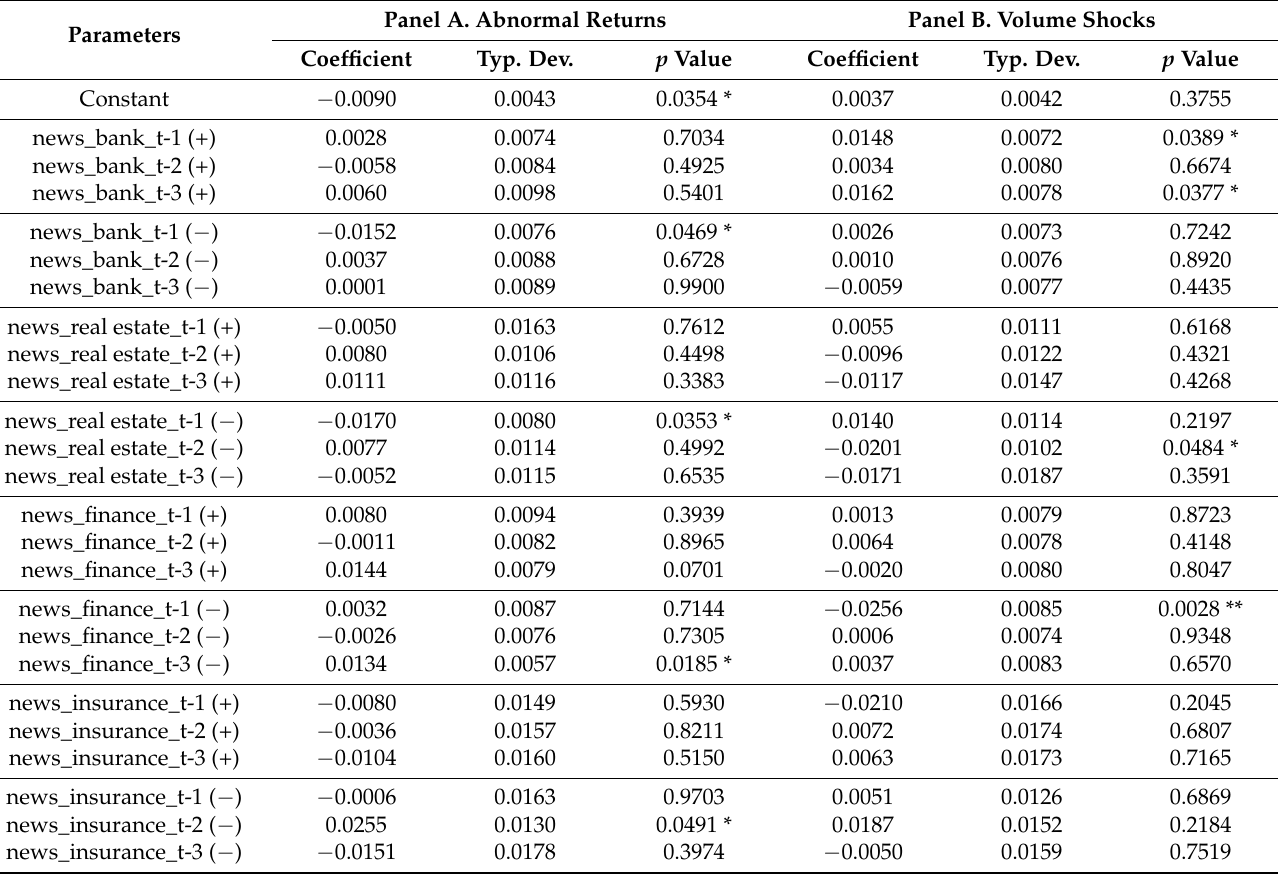
Table 8. Estimate of the asymmetric and subsector influence of the investor sentiment index. Panel A. Abnormal Returns Panel B. Volume Parameters